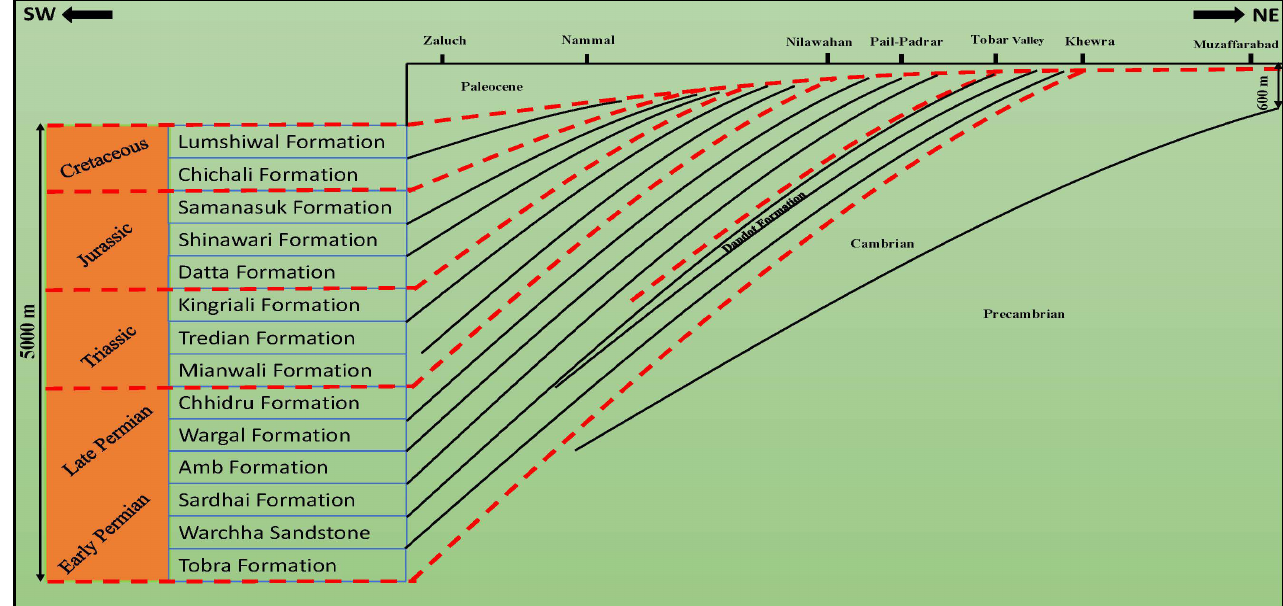
Figure 2. Surface and subsurface deposition of different formations and unconformities in UIB and HKS.